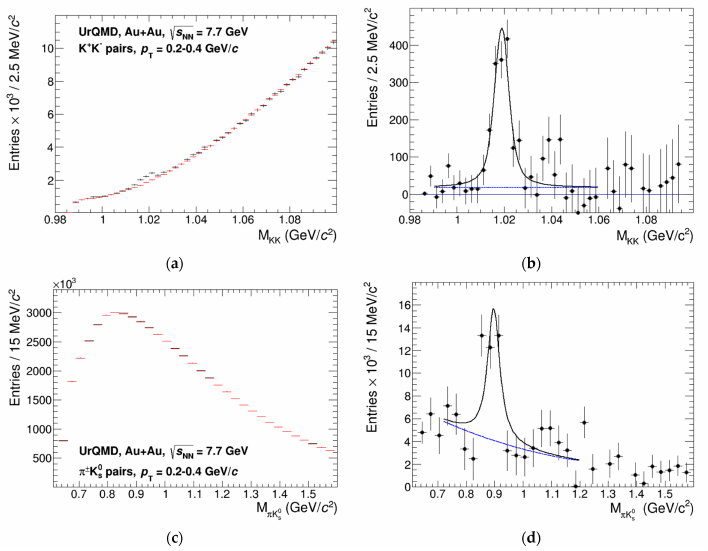
Figure 8. The invariant mass distributions accumulated for K + K − ( a , b ), and π ± K 0 s ( c , d ) pairs in √ s NN = 7.7 GeV in the momentum range 0.2–0.4 GeV/ c . The distributions 5 · 10 6 Au + Au collisions at are shown before ( a , c ) and after ( b , d ) the mixed-event background subtraction. The plots (a,c) show the foreground (black) and the mixed-event (red) invariant mass distributions (taken from Ref.